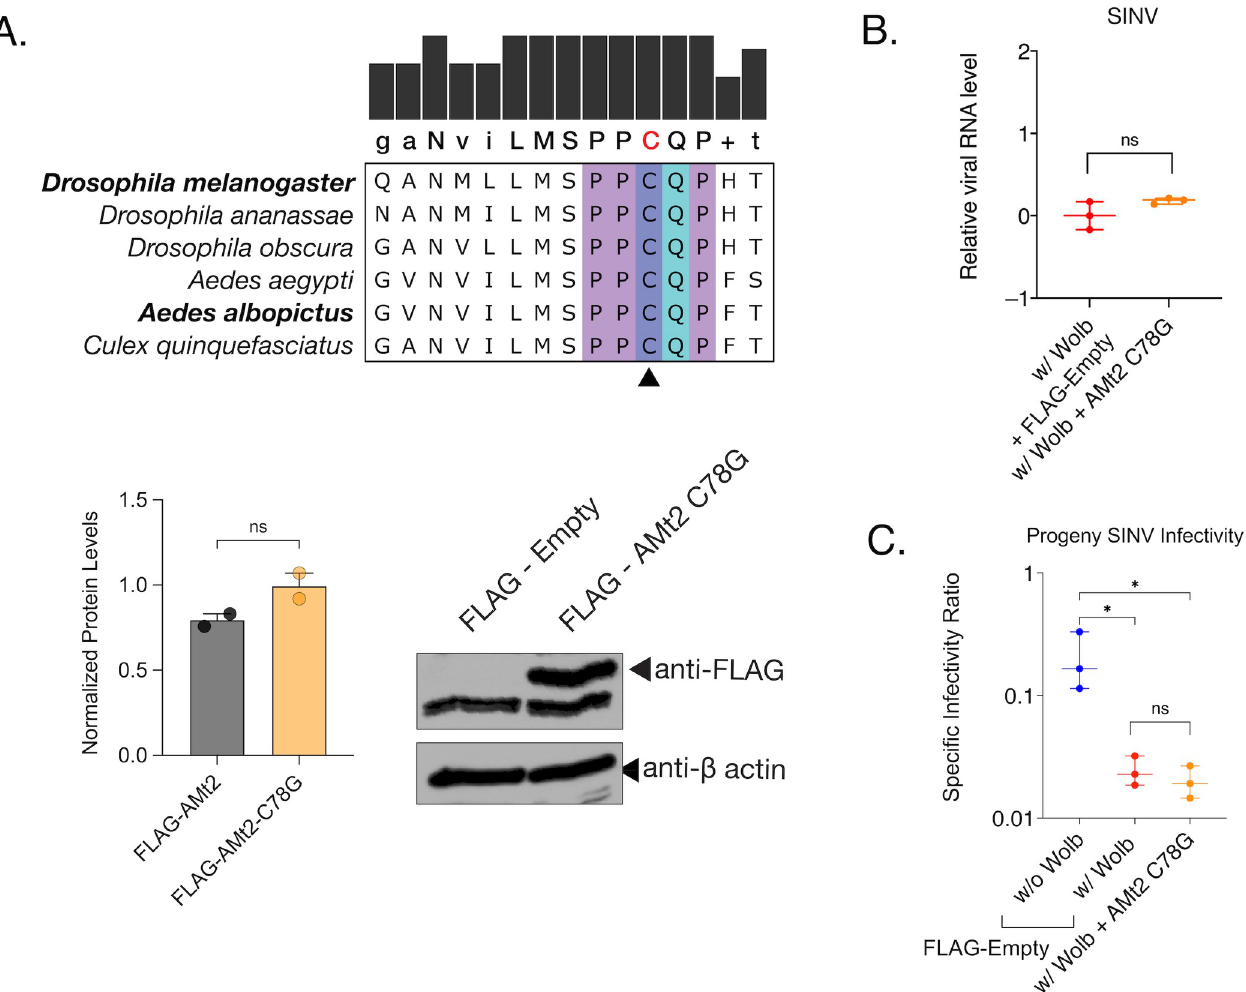
Fig 5. Catalytically inactive DNMT2 is unable to rescue Wolbachia -mediated virus inhibition in mosquito cells. ( A) Multiple sequence alignment of the Motif IV region of DNMT2 derived from dipterans that are known to be colonized with native or non-native Wolbachia . The conserved catalytic cysteine (C) residue, depicted in red on the consensus sequence at the top, was mutated to a glycine (G) to abolish MTase activity of mosquito AMt2. Expression of the catalytic mutant (AMt2 C78G) was determined at 48 hours post transfection using Western Blot. C7/10 mosquito cells transfected with expression vector constructs with (FLAG-AMt2 C78G) or without (FLAG-empty) AMt2 . Cytoplasmic lysates of cells were collected 48 hours post transfection and probed with anti-FLAG antibody. Bar graphs represent wild-type (example in Fig 2A) and C78G AMt2 mutant protein levels normalized to β -actin controls. (B) C7/10 mosquito cells with Wolbachia were transfected with expression vectors FLAG-empty (w/ Wolb) or FLAG-C78G AMt2 (w/ Wolb + AMt2 C78G) for 48 hours prior to infection with SINV at MOI of 10. Viral RNA was quantified using quantitative RT-PCR as before. Unpaired t-test with Welch’s correction, p = 0.1734, t = 1.920, df = 2.396. (C) C7/10 mosquito cells with and without Wolbachia were transfected with expression vectors FLAG-empty (w/o Wolb, w/ Wolb) and FLAG-C78G AMt2 (w/ Wolb + AMt2 C78G) for 48 hours prior to infection with SINV at MOI of 10. Specific Infectivity (SI) of progeny viruses produced after 72 hours post infection were quantified as before. One-way ANOVA with Dunnett’s test for multivariate analyses. w/o Wolb vs w/ Wolb, p = 0.035, w/o Wolb vs w/ Wolb + AMt2 C78G p = 0.032, w/ Wolb + AMt2 vs w/ Wolb + AMt2 C78G p = 0.9963. Error bars represent standard error of mean (SEM) of biological replicates. � P < 0.05, ns =